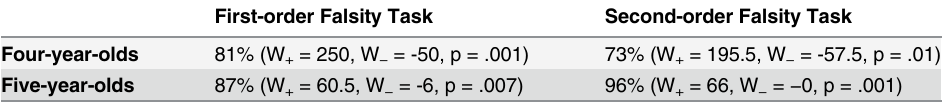
Table 3. Percentage of Successes (Comparison to Chance, One-sample WSRT) on the First-Order and Second-Order Falsity Tasks of Study